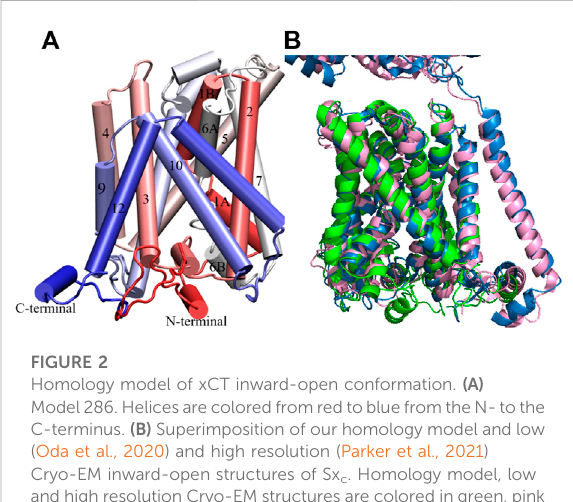
FIGURE 2 Homology model of xCT inward-open conformation. (A) Model286.HelicesarecoloredfromredtobluefromtheN-tothe C-terminus. (B) Superimposition of our homology model and low (Oda et al., 2020) and high resolution (Parker et al., 2021) Cryo-EM inward-open structures of Sx c . Homology model, low and high resolution Cryo-EM structures are colored in green, pink and blue,